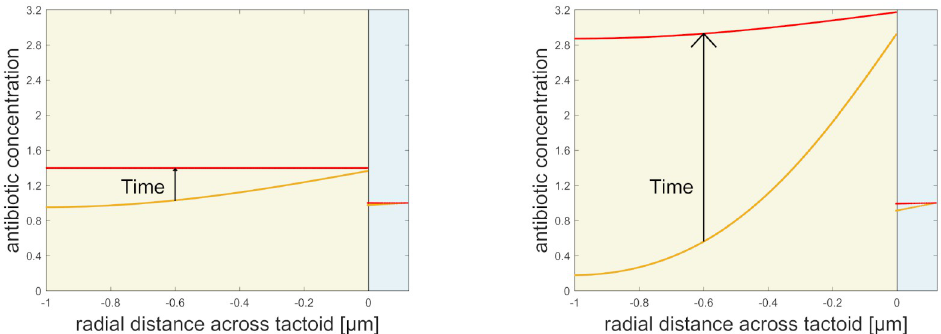
Fig 4. Distribution of antibiotics (both free and adsorbed) across the tactoid. Left and right figures show different equilibrium adsorption coefficients: left is α = 0.4 μ m (isotropic), right is α = 2.2 μ m (nematic). Each figure shows the antibiotic concentration distribution after 10s (orange line), and 100s (red line). The time progression is indicated by an arrow. The distance covered ranges from the bacterium boundary at -1 μ m, to just beyond the outer tactoid boundary at 0 μ m; the tactoid domain is indicated by a yellow background and the outer domain is blue. The discontinuity in the antibiotic concentration of the outer tactoid boundary is due to the lack of bound antibiotics outside the